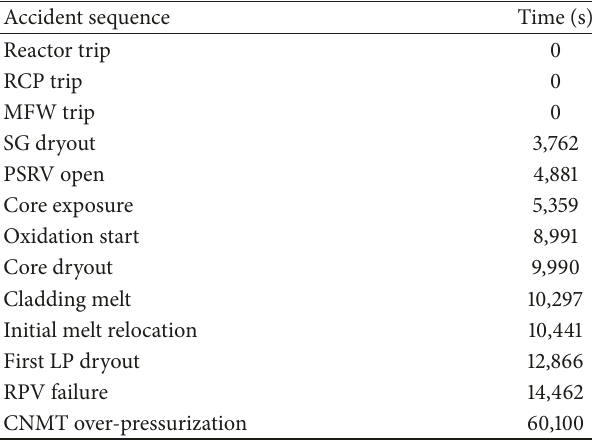
Figure 3: RCS pressure in the base case (STSBO).